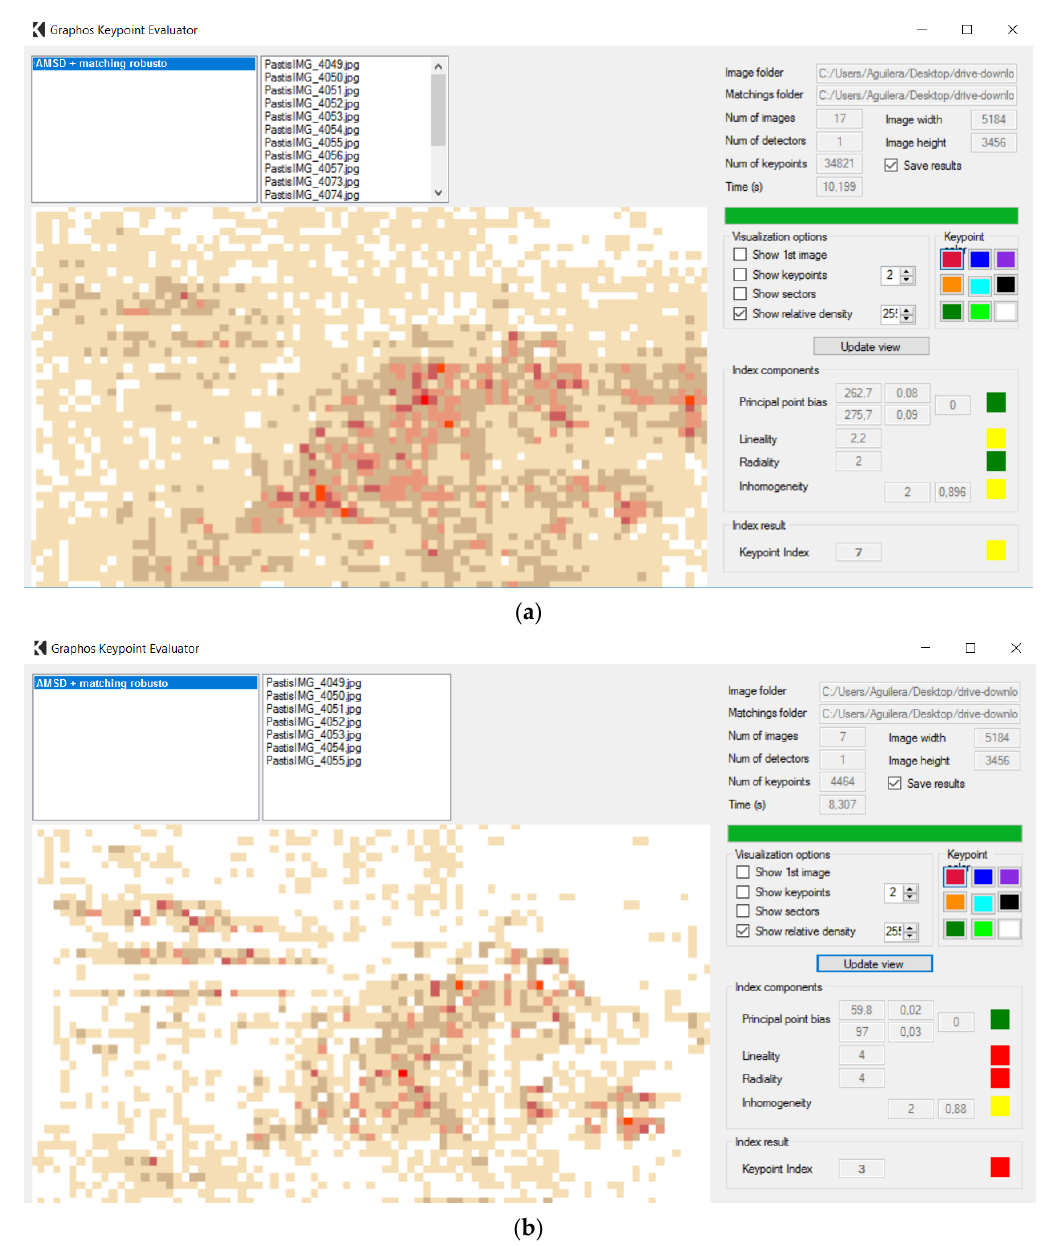
Figure 8. Results obtained during the analysis of the distribution of the key points extracted along the camera’s sensor: ( a ) AMSD, robust matching, and camera´s sensor spatial filtering; and ( b ) AMSD and robust matching without camera sensor´s spatial filtering.